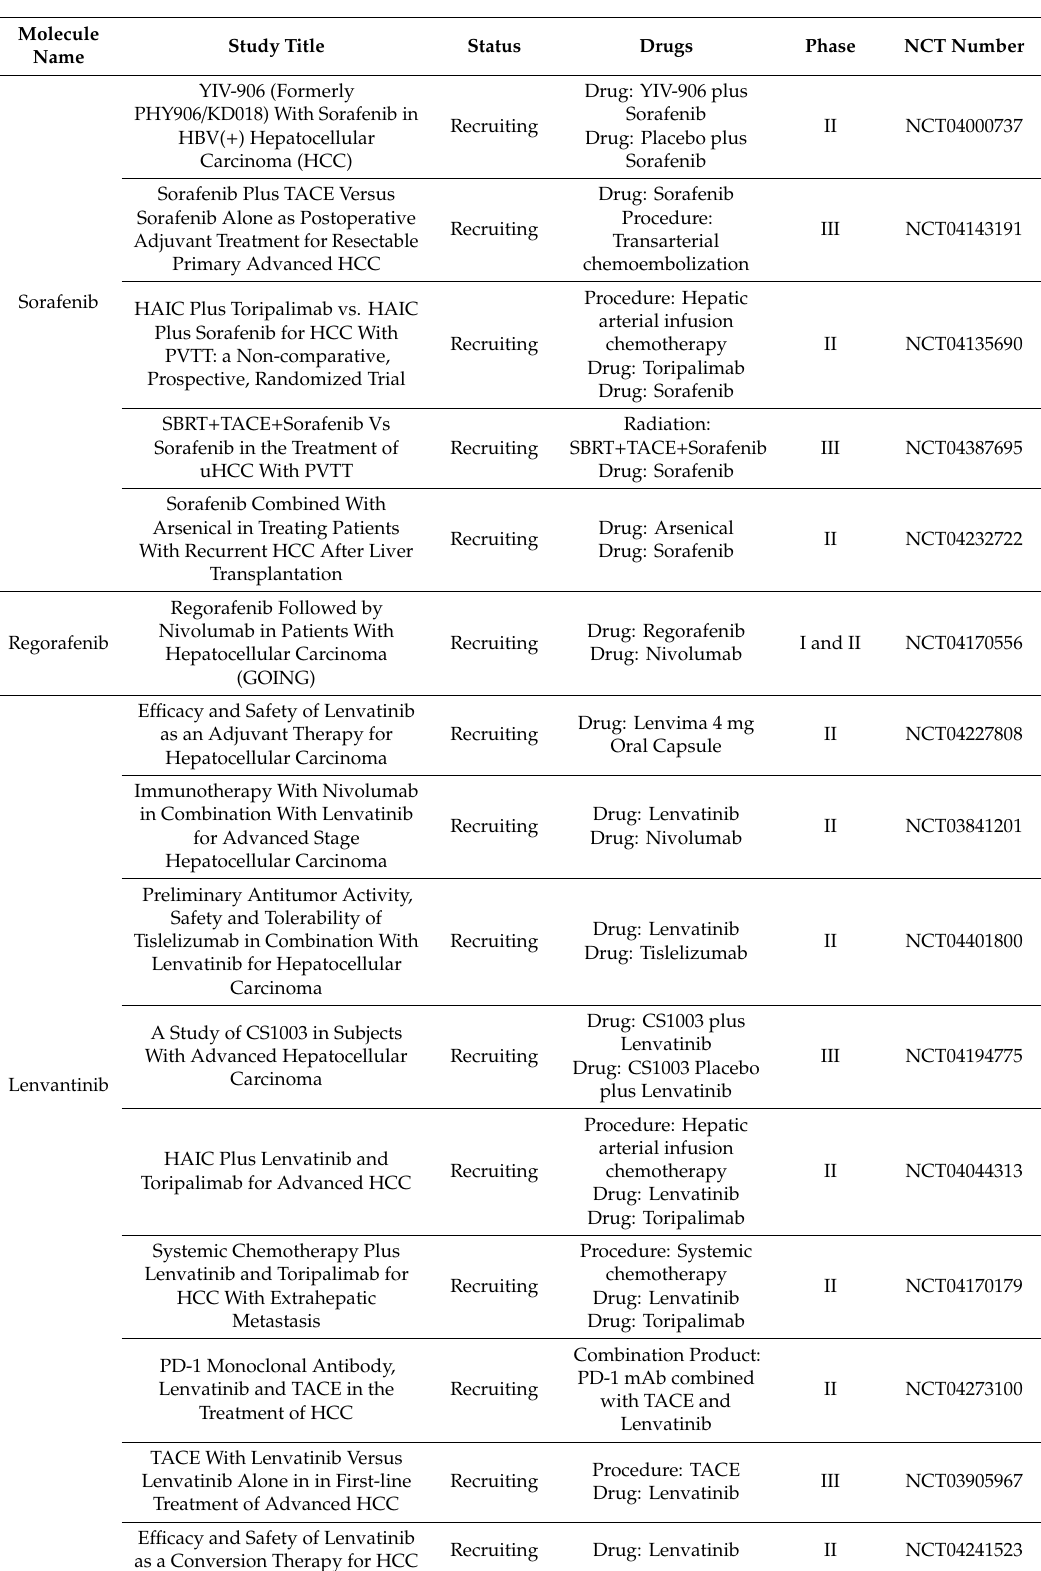
Table 2. Ongoing clinical trials investigating the use of tyrosine-kinase inhibitors for hepatocellular carcinoma